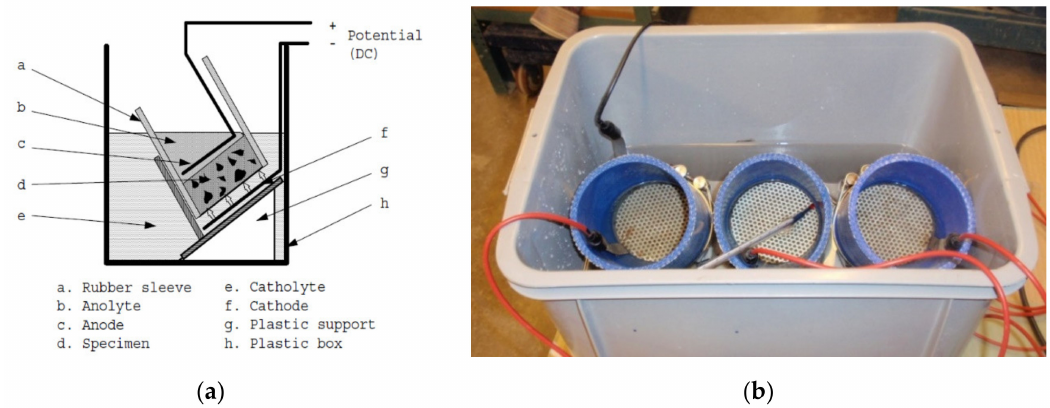
Figure4. TestsetupoftheRapidChlorideMigrationtest. ( a )Schematicrepresentation[10]; ( b )Execution of the tests.